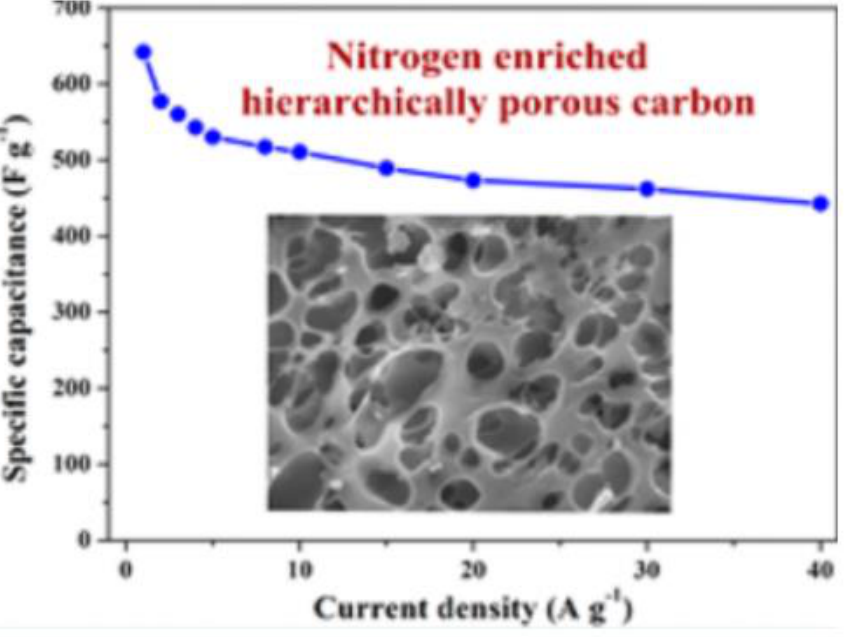
Figure 33. Polybenzoxazine based hierarchically porous carbons (reproduced from the work in [83] with permission).